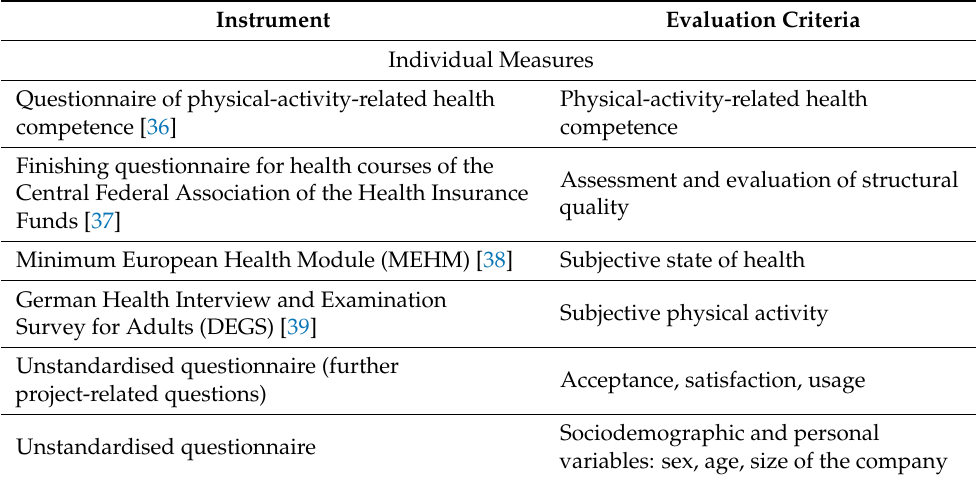
Table 3. Instruments of quantitative evaluation (individual and short measures, and online